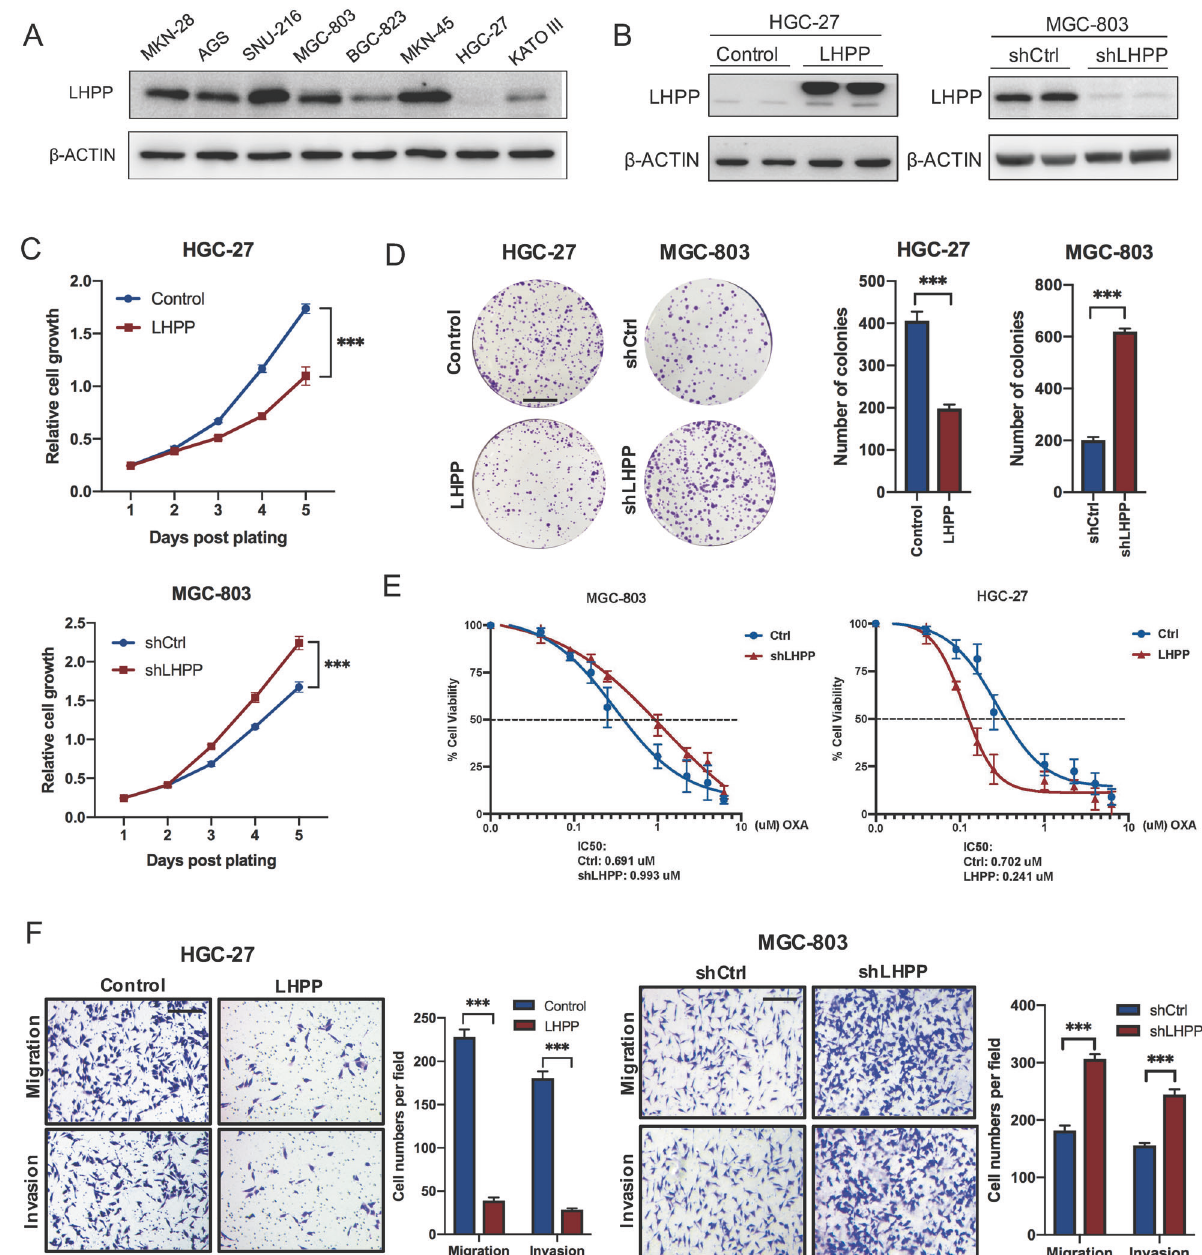
Fig. 2 LHPP inhibits GC proliferation and metastasis in vitro. A Basic protein expression of LHPP in GC cell lines (MKN-28, AGS, SNU-216, MGC-803, BGC, MKN-45, HGC-27 and KATO III) was detected by western blotting. B HGC-27 cells with stable LHPP overexpression or MGC-803 cells with LHPP knockdown were created. The changes in LHPP expression were con fi rmed using western blotting. C , D The proliferative ability of stably transfected HGC-27 or MGC-803 cells was investigated via CCK-8 assays and colony formation. CCK-8 data were analyzed using a two-way analysis of variance. Colony number data were analyzed using the Wilcoxon test. Scale bars = 1 cm. E The drug resistance of stably transfected HGC-27 or MGC-803 cells was investigated via IC 50 assays and colony formation. F Transwell assays with stably transfected HGC-27 and MGC-803 cells were performed. Representative images and quanti fi cation of the results are presented. Scale bars = 100 μ m. Cell number data were analyzed using the Wilcoxon test. *** P < 0.001, GC gastric cancer, OXA